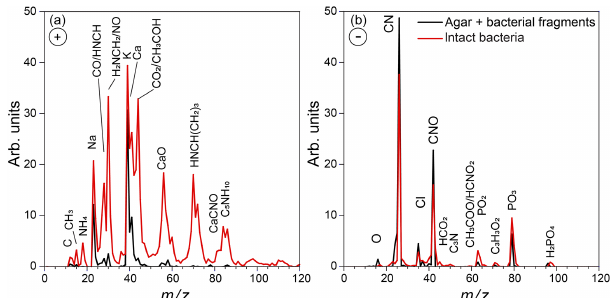
Figure 8. Positive (a) and negative (b) average mass spectra of the particles in the AIDA chamber, measured before Expansion 2. Ref- erence mass spectra of the small size mode, made up of particles smaller than 300nm (black), and the mass spectra of the large size mode (>700nm) composed of intact PF CGina bacterial cells are marked in red.